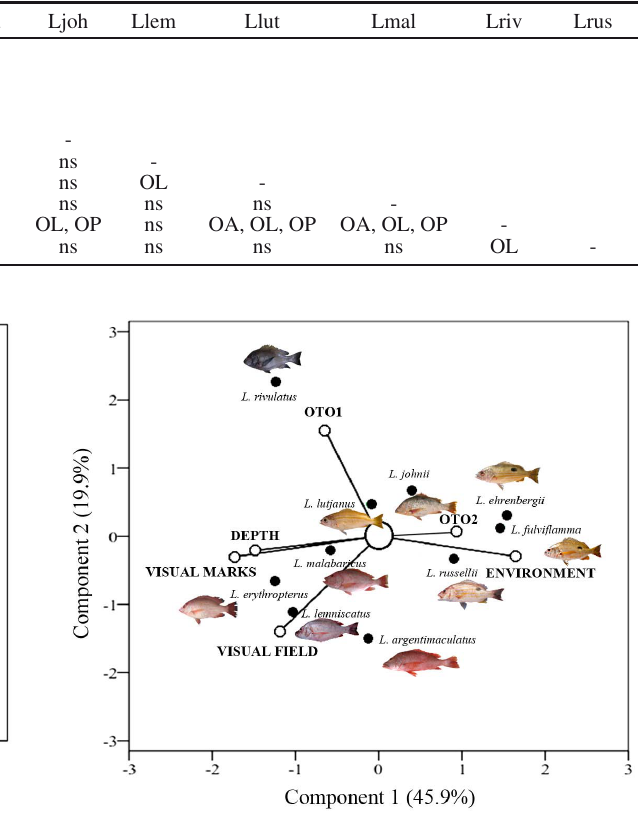
Table 4. − Otolith variables presenting significant differences (Tukey’s test) in the slope of relationships between fish length and otolith vari- ables among snappers from the Persian Gulf. ns, not significant; OA, otolith area; OH, otolith height; OL, otolith length; OP, otolith perimeter; OW, otolith weight. Differences are significant (p<0.05) when otolith variables appear.